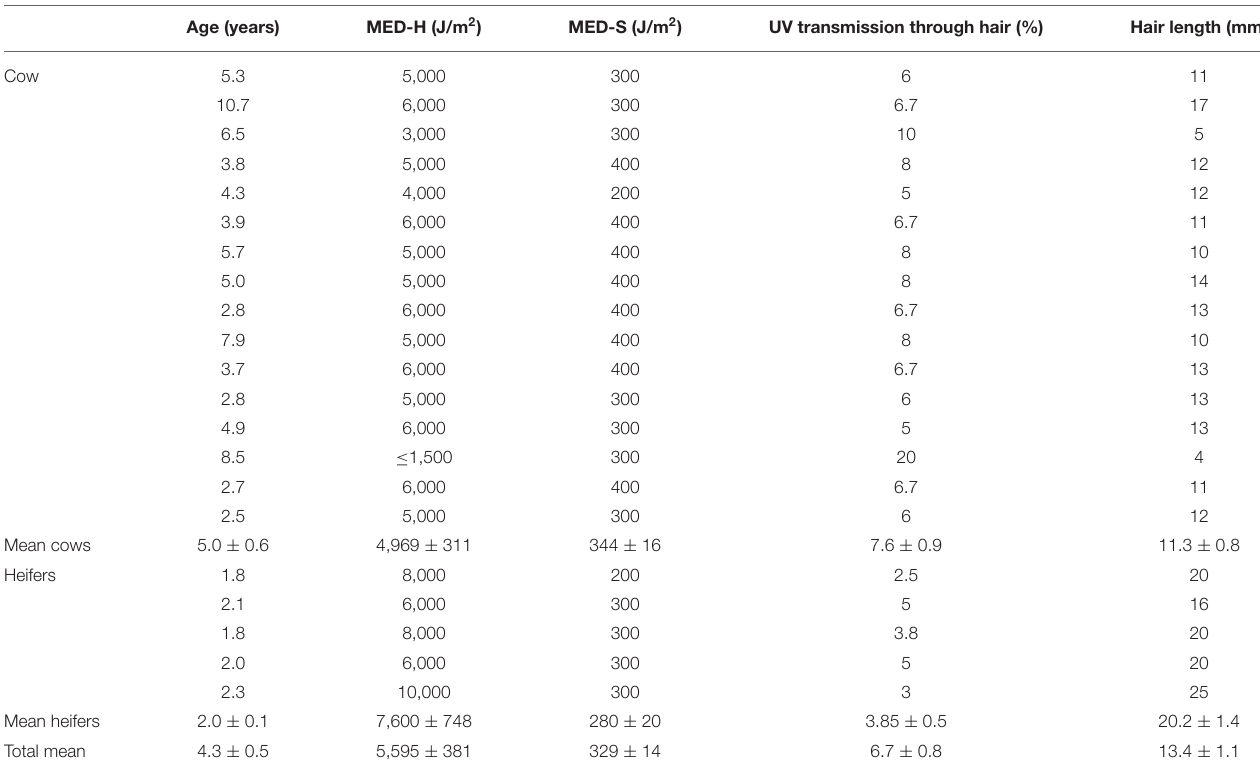
TABLE 2 | Results of UV irradiation.